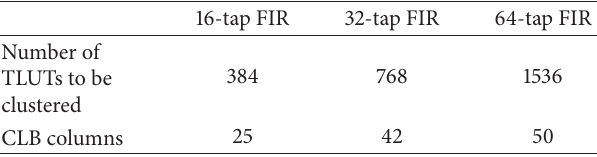
Table 5: CLB columns TLUTs placed without placement con-